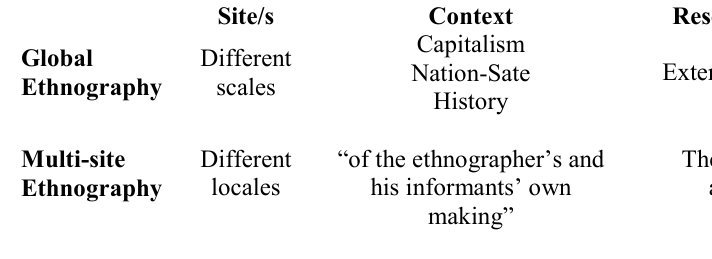
Table 1: GE and MSE Along Four Dimensions Site/s